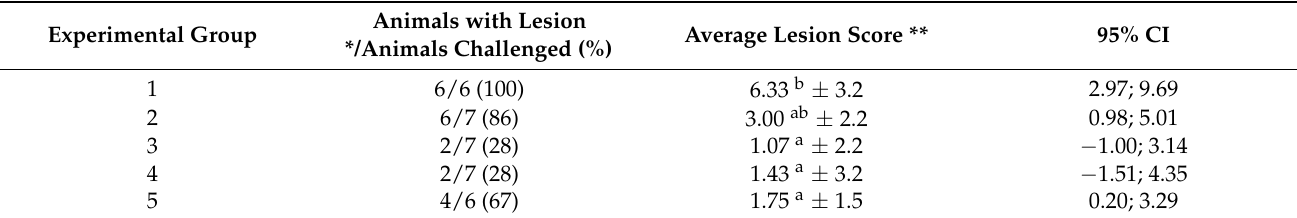
Table 4. Number and percentage of animals with visible lesions, average, standard deviation, and 95% confidence intervals for lesion scores after vaccination against TB and challenged with a wild-type strain in a goat